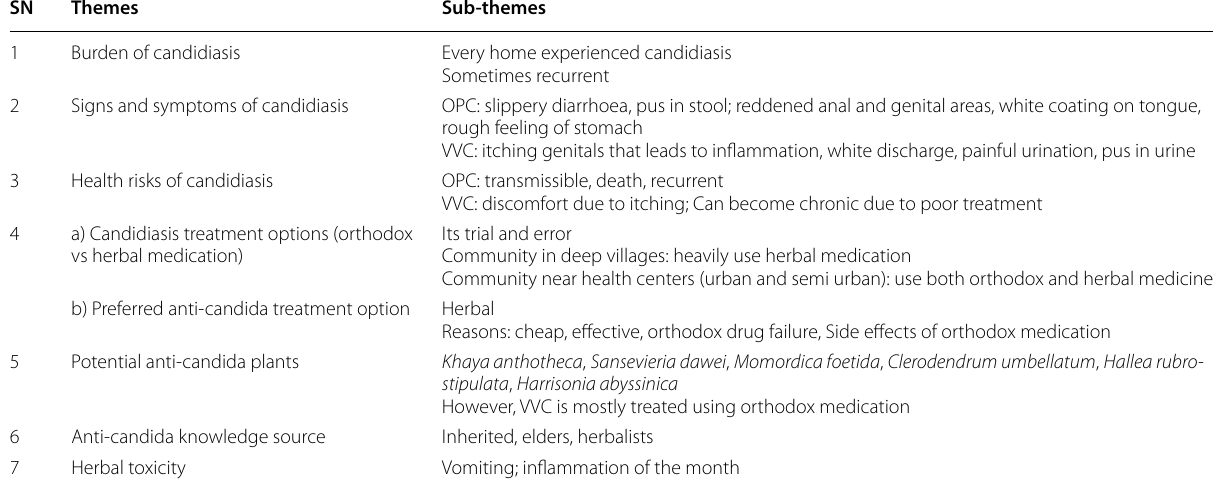
Table 7 Focus group discussion to ascertain community (non-herbalists) knowledge on candidiasis and treatment options